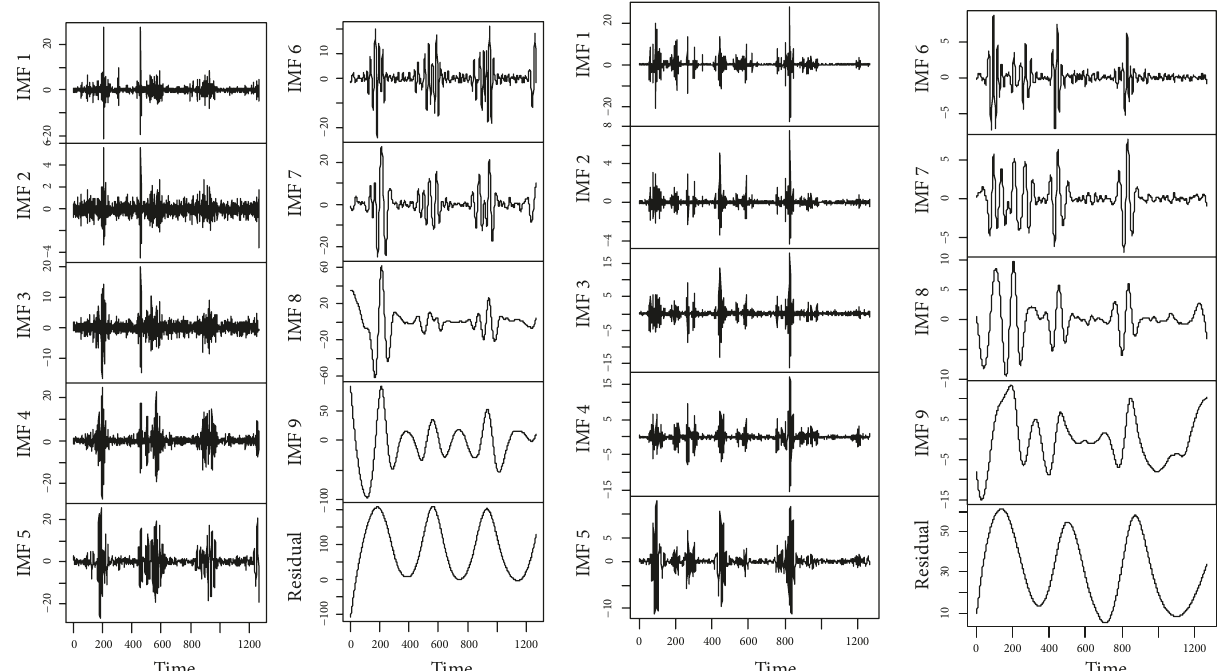
Figure 7: The WA-CEEMDANdecomposition of Indus (left) and Jhelumrivers inflow (right). The two series are decomposed into nine IMFs and one